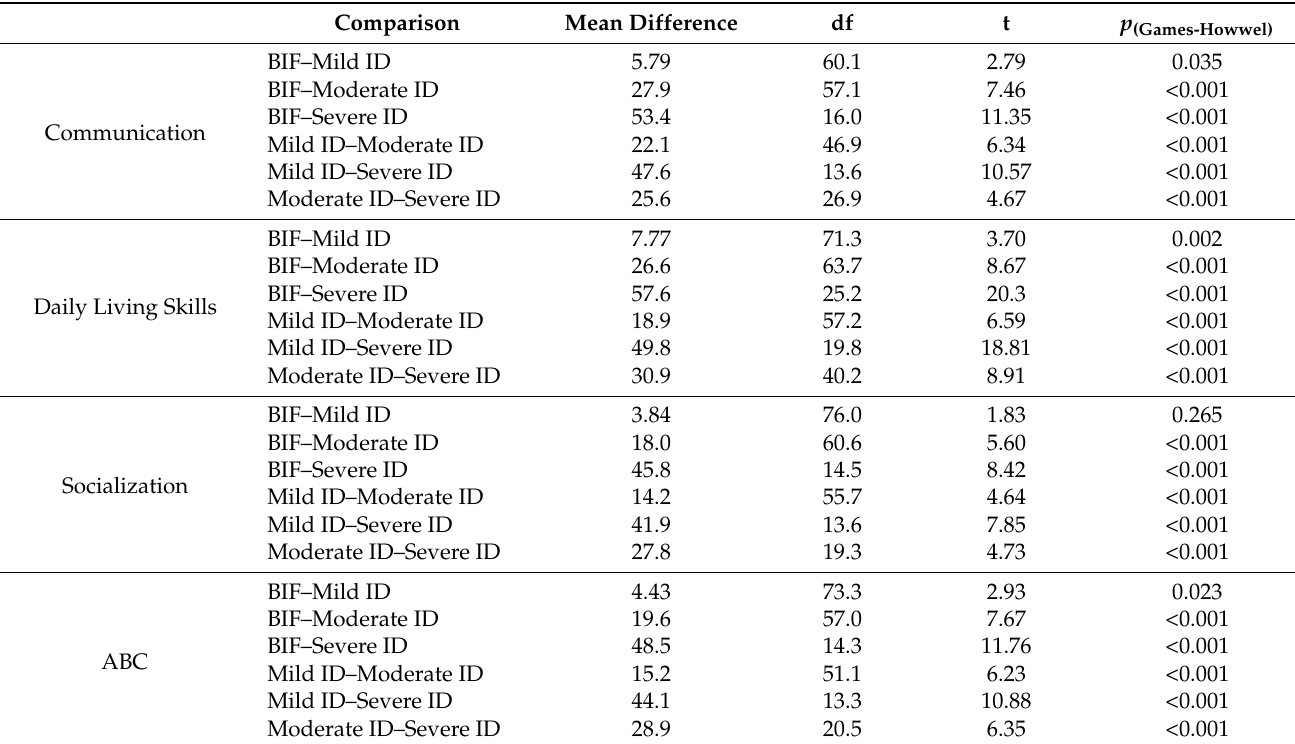
Table A1. Post hoc comparisons of AB domain in different levels of ID.